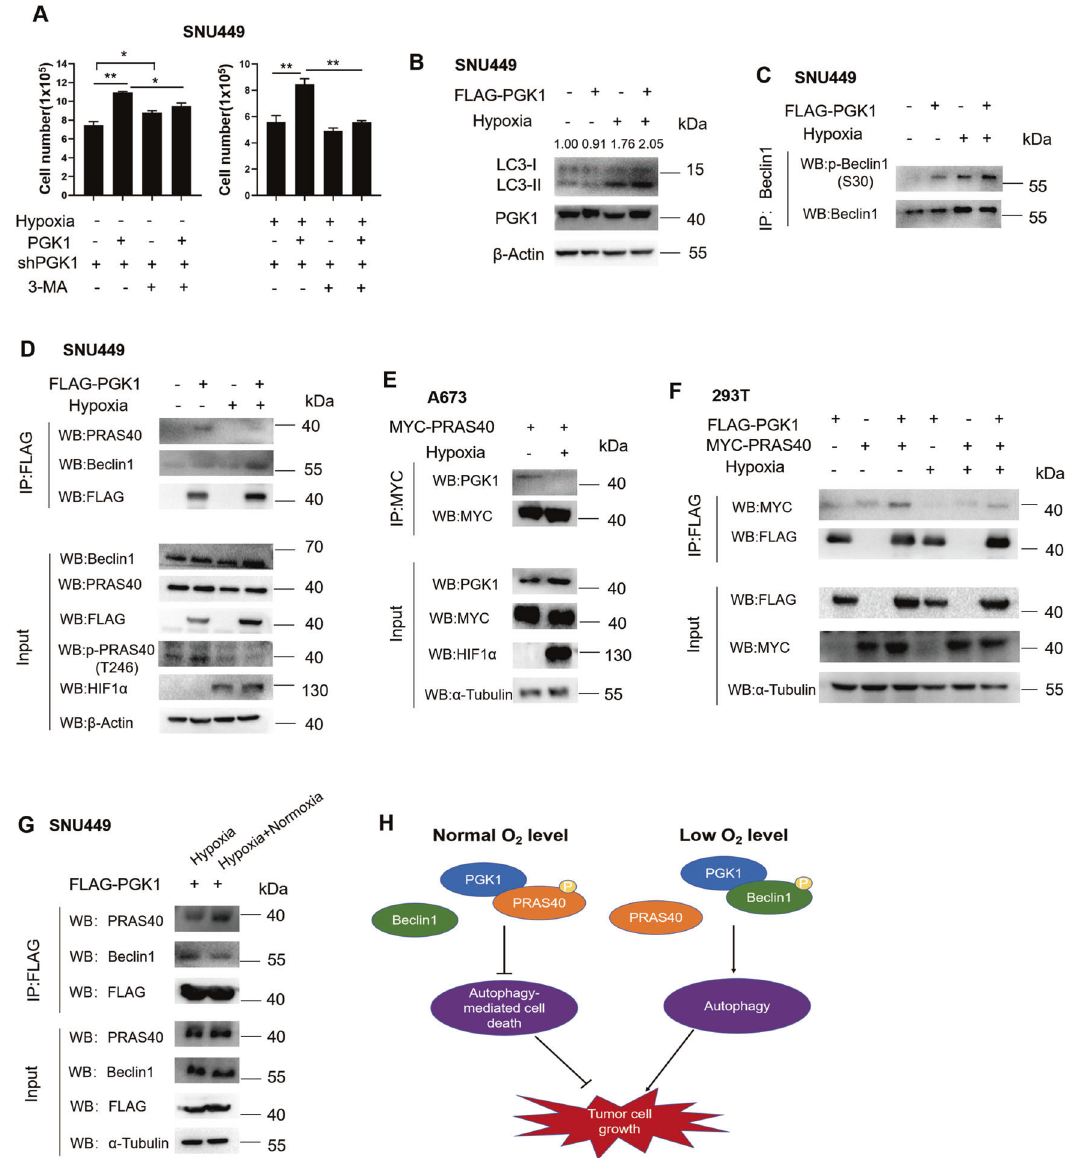
Fig. 6 The relationship of PGK1 and PRAS40 under hypoxia. A Cell counting for the indicated cells. PGK1-depleted cells reintroduced with control or shRNA-resistant FLAG-PGK1 expression vector were treated with or without 3-MA and cultured under normal (21%, − ) or lower oxygen level (1%, Hypoxia + ) for 48 h. Data represent mean ± SD. * P < 0.05; ** P < 0.01. B – F The indicated cells were seeded and cultured under normal oxygen level for 24 h, and were kept under normal oxygen level (21%, − ) or shifted to lower oxygen level (1%, Hypoxia + ) for another 24 h. Cell lysates were applied to western blotting analysis ( B ), or Co-IP followed by Western blotting with the indicated antibodies ( C – F ). G The PGK1-overexpressing cells were cultured under lower oxygen level for 24 h, and were kept under lower oxygen level (Hypoxia) or shifted to normal oxygen level (Hypoxia + Normoxia) for another 6 h. Cell lysates were applied to Co-IP followed by western blotting with the indicated antibodies. H Schematic graphs representing the working model of the interaction of PRAS40 and PGK1. The quanti fi cation results of the band density were labeled above the